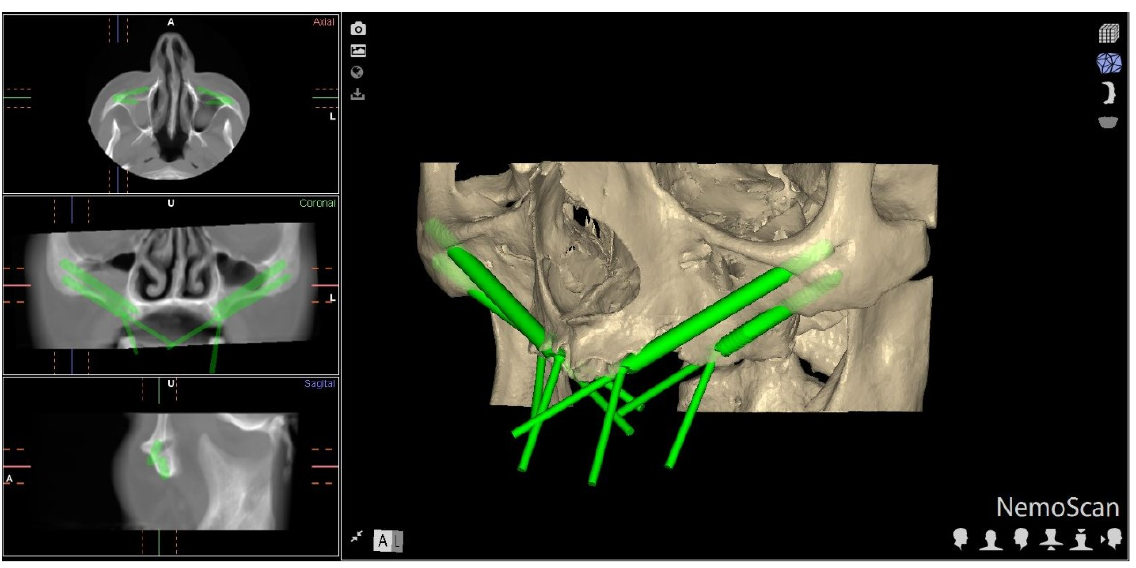
Figure 1. Preoperative planning of ZI placement based on the CBCT scan taken of the patient. Detail of the coronal, sagittal, and axial views, and three-dimensional reconstruction. ditions (Figure 2).